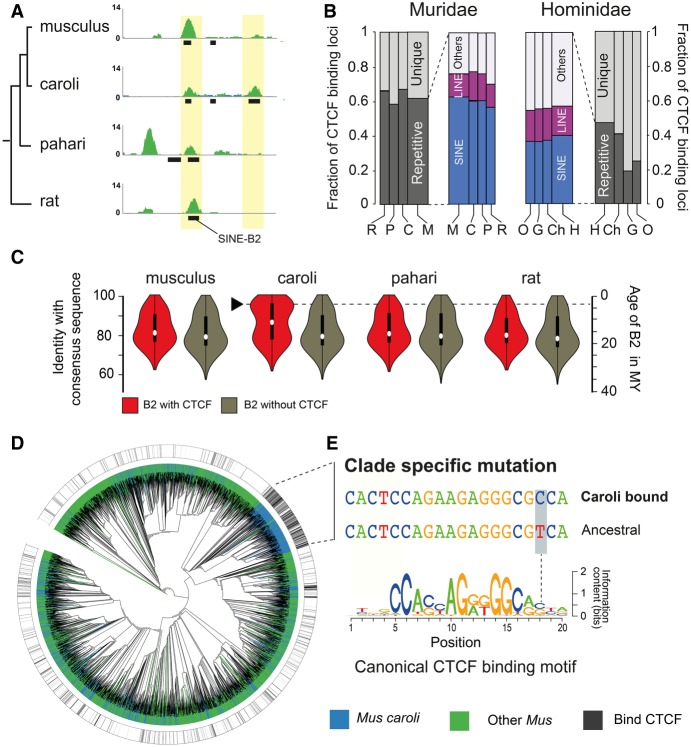
A single nucleotide mutation in a Mus caroli–specific expanding SINE B2 element contributed to the creation of thousands of novel CTCF binding events. (A) CTCF occupancy in the genome is shown by green tracks. The black squares show the location of SINE B2 retrotransposons. The yellow boxes represent two examples of a SINE B2 occupied by CTCF. (B) Fraction of transposable elements with CTCF binding in both Muridae (left) and Hominidae (right): (M) Mus musculus; (C) Mus caroli; (P) Mus pahari; (R) rat; (H) human; (Ch) chimpanzee; (G) gorilla; (O) orangutan. (C) Identity plots of SINE B2 with their consensus sequence, either occupied by CTCF (red) or not (brown) (Supplemental Methods SM4.1). The black arrow indicates a recent wave of SINE B2 expansion carrying CTCF binding sites in Mus caroli. (D) Neighbor-joining tree of SINE B2_Mm1 sequences from the three Mus species. The blue branches represent sequences from Mus caroli. The green branches represent sequences from Mus musculus or Mus pahari. The black lines in the outside tracks indicates the presence of a CTCF binding event. (E) A single nucleotide variation exists between the ancestral CTCF binding motif carried by the SINE B2_Mm1 element (middle) and a CTCF binding motif (top) carried by the elements recently expanded in Mus caroli. This branch-specific motif is enriched in CTCF occupancy.